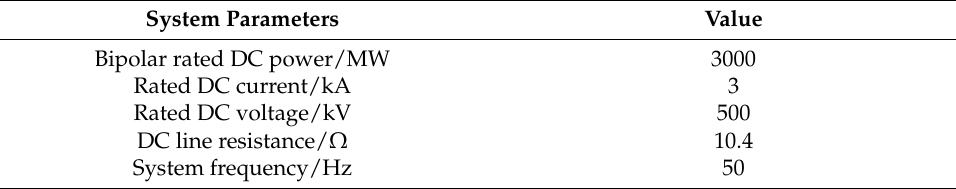
Table 3. System parameters of the LCC-CCC HVDC transmission system.